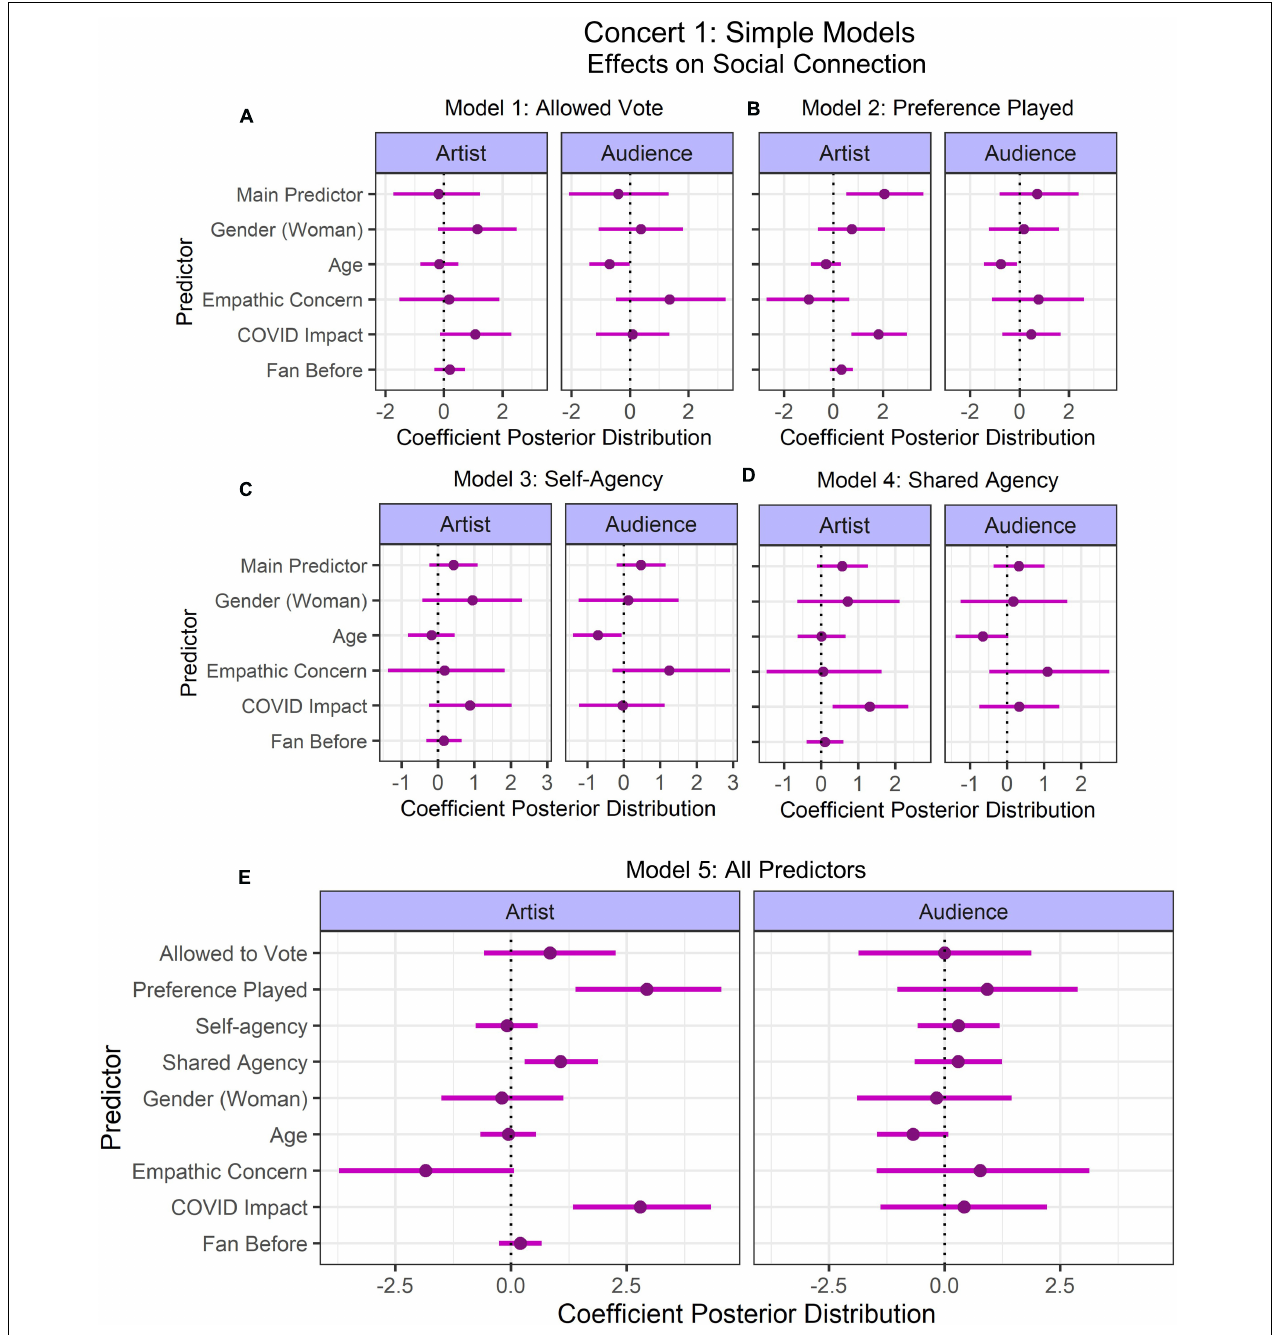
FIGURE 3 | Concert 1’s simple models’ predictor coefficient estimates (points) and 90% credible intervals (lines) for the effects on social connection to the artist (left) and audience (right). Five models were fit to examine the individual contributions of (A) Allowed to Vote, (B) Preference Played, (C) Self-agency, (D) Shared Agency, and one model was fit to examine all predictors (E) . Lines indicate the 90% credible intervals (i.e., there is a 90% posterior probability that the coefficient of the predictor lies in that range). Credible intervals not intersecting 0 indicate that there is at least a 90% probability that the effect of that predictor on social connection is positive or